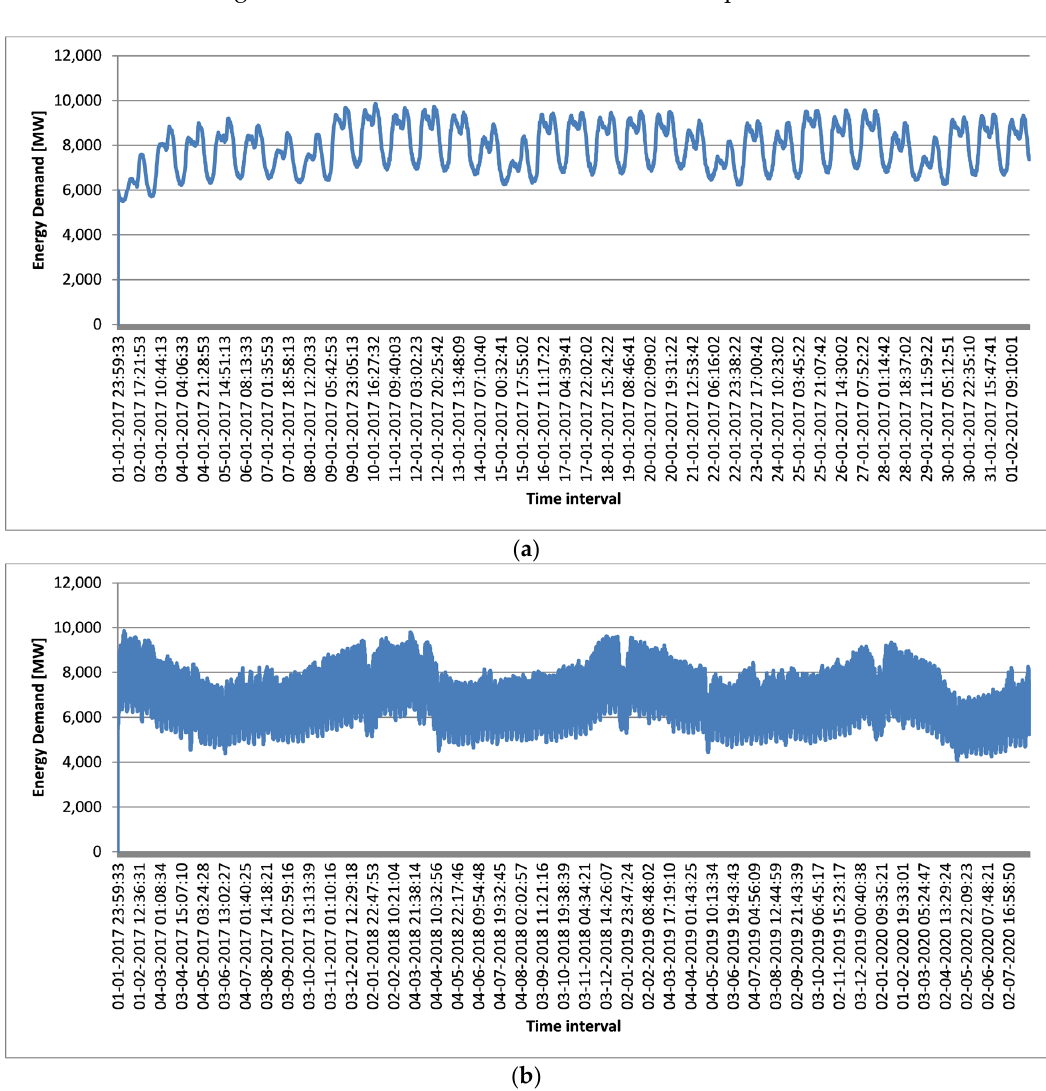
Figure 1. Cyclic evolution of the consumption: ( a ) over one month and ( b ) over three years (adapted from [10]).